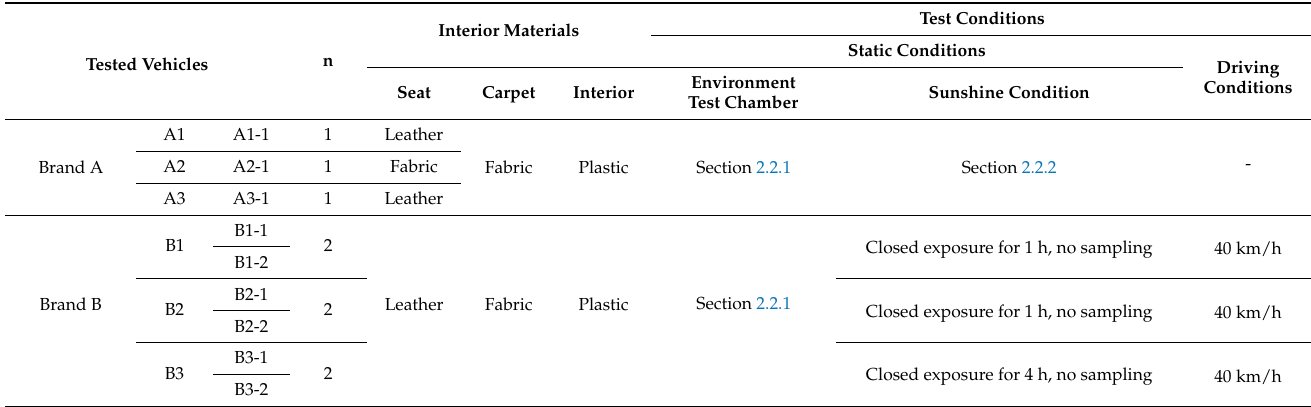
Table 1. Vehicles under study and corresponding test